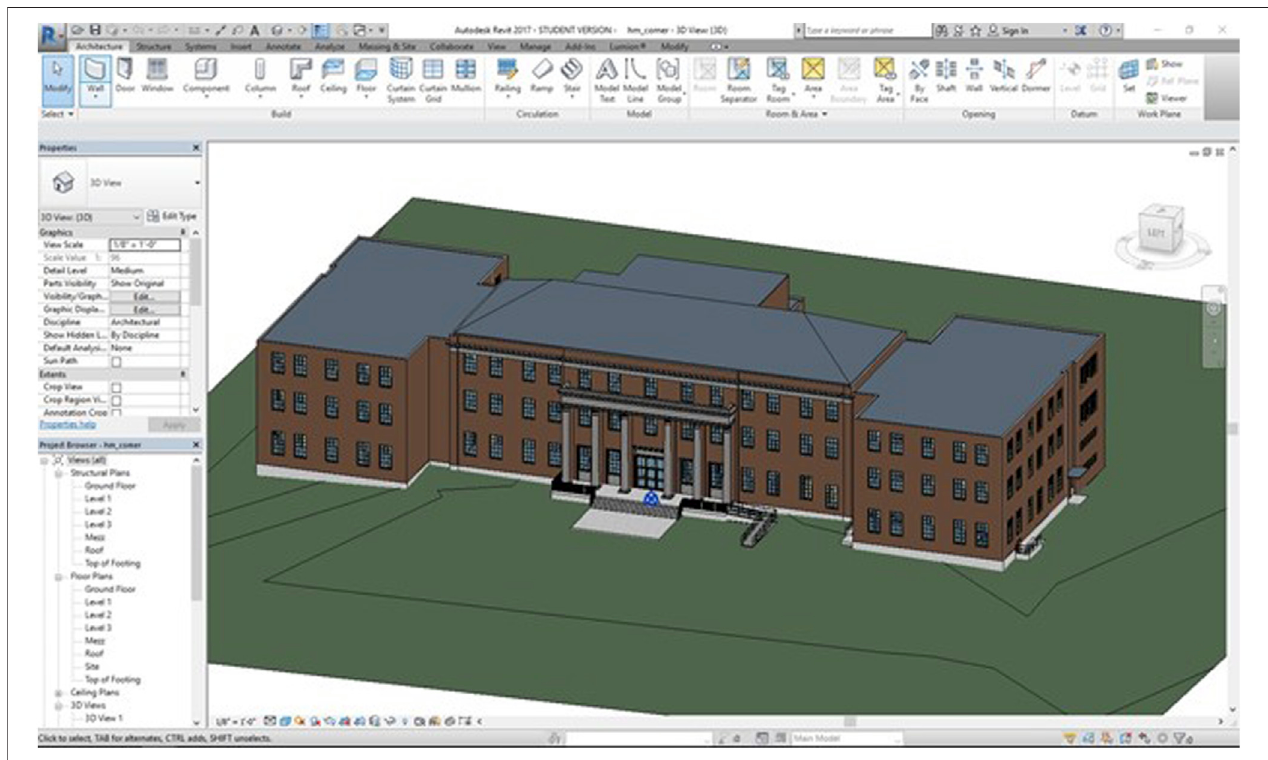
FIGURE 3 | 3D model of H.M. Comer Hall in Revit